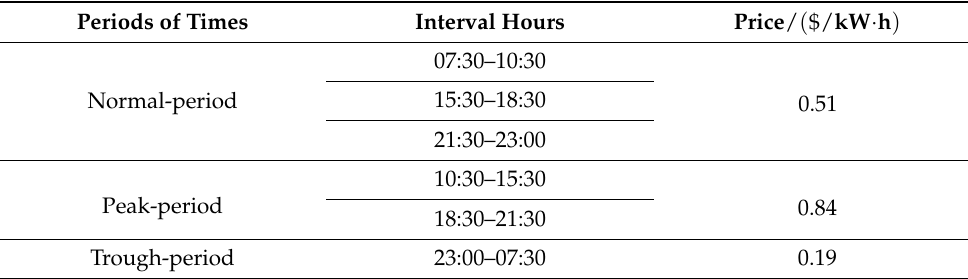
Table 7. The electricity consumption price on the electricity meter by measuring daily